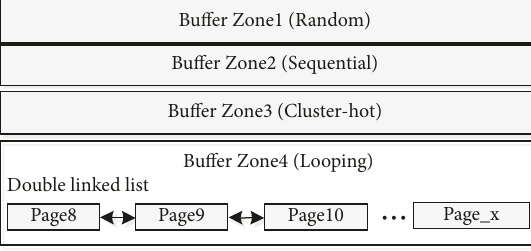
Figure 3: Four data buffer zones.